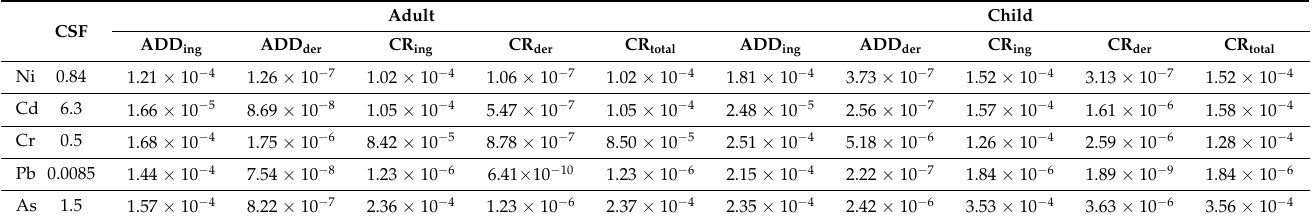
Table 5. Cancer slope factor (CSF) (mg/kg/day) − 1 , average daily exposure dose (ADD) (mg/kg/day), and carcinogenic risk (CR) for health risk assessment of carcinogenic trace elements (subscript “ing”: ingestion; subscript “der”: dermal). Adult CSF ADD